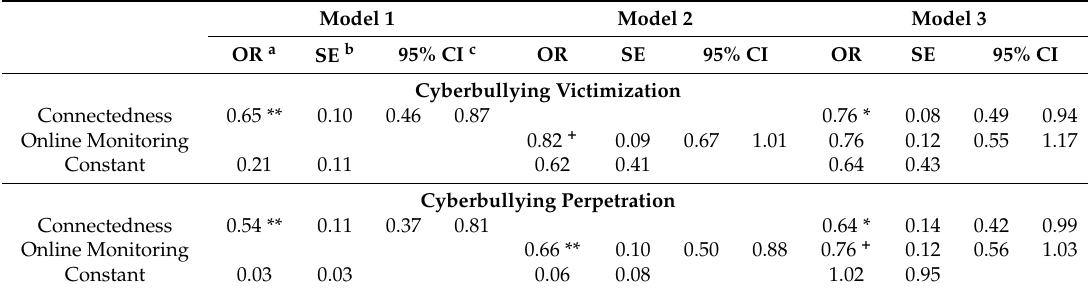
Table 2. Results of multivariable logistic regression models of parental connectedness and monitoring of online activities on cyberbullying victimization and perpetration ( n = 570).